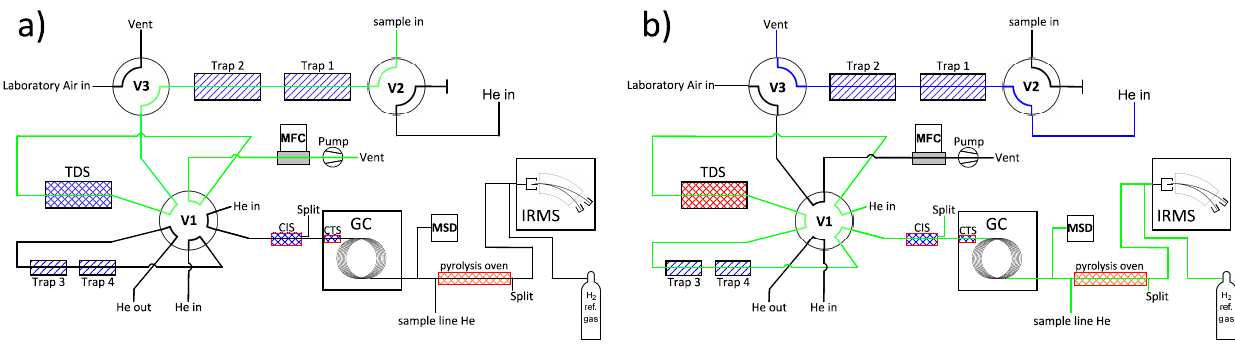
Figure 1. Schematic of the measurement system in the pre-concentration mode (a) : the sample volume is drawn through traps 1 + 2 (reduction of water) and TDS, where the VOCs are trapped. A sample gas stream is represented by the green line. System in transfer mode (b) : the sample is desorbed from TDS through traps 3 + 4 (water reduction) to CIS and CTS for cryogenic focussing. After desorption from the CTS the VOCs are chromatographically separated and detected in the MSD as well as in the IRMS after passing the pyrolysis oven. The sample gas stream is represented as a green line, whereas the blue line shows a helium flow for purging the TDS and traps 1 + 2 after desorption. See text for more